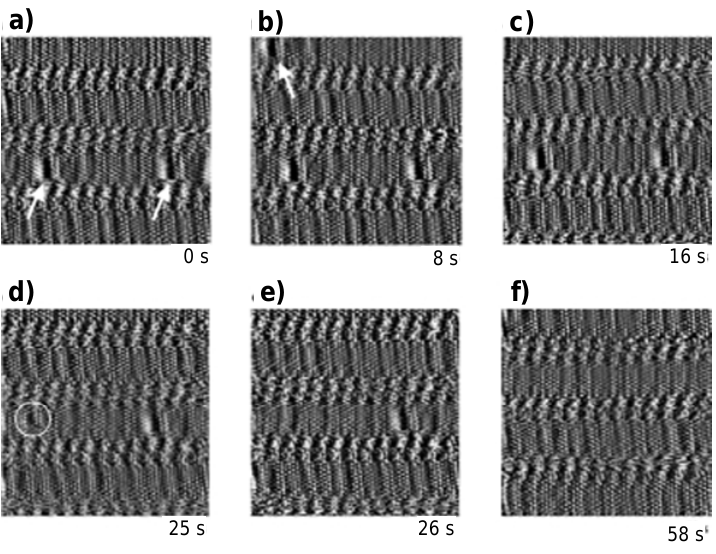
Figure 9. Dynamic processes during co-adsorption of perfluorinated and non-fluorinated isophthalic acid derivatives on HOPG. Reproduced with permission from reference